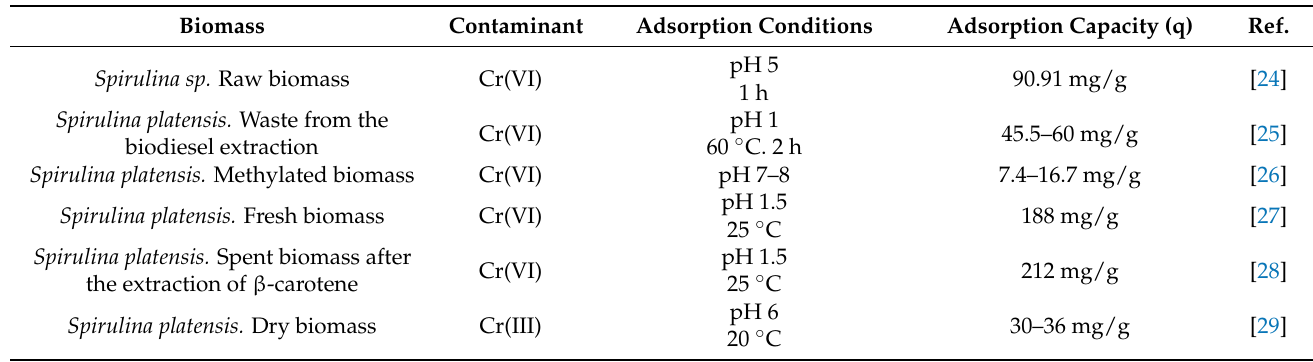
Table 7. Adsorption of Cr on spirulina